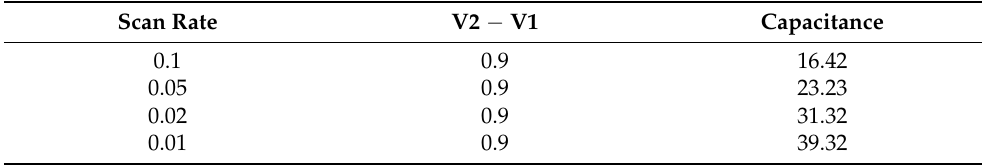
Figure 7. The cyclic voltammetry (CV) for the fabricated EDLC at various scan rates. Table 3. Specific capacitance ( C s ) of the EDLCs using CV curves.